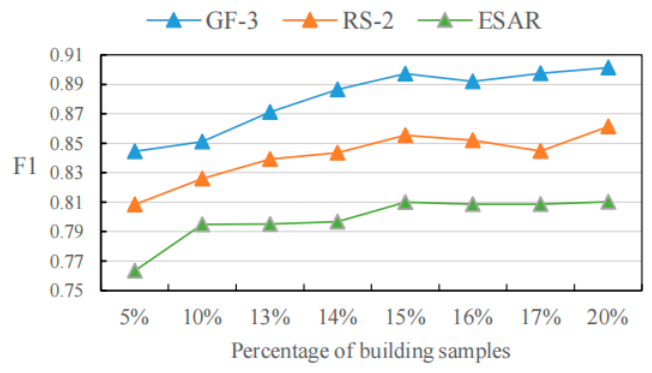
Figure 13. Building elements used for training account for the accuracy of building extraction results at different percentages of all building pixels. at different percentages of all building